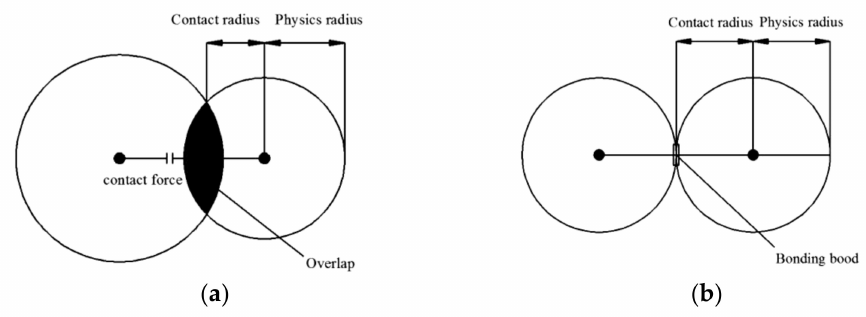
Figure 4. Modeling method of non-spherical particles: ( a ) multi-sphere method, ( b ) bonded particle